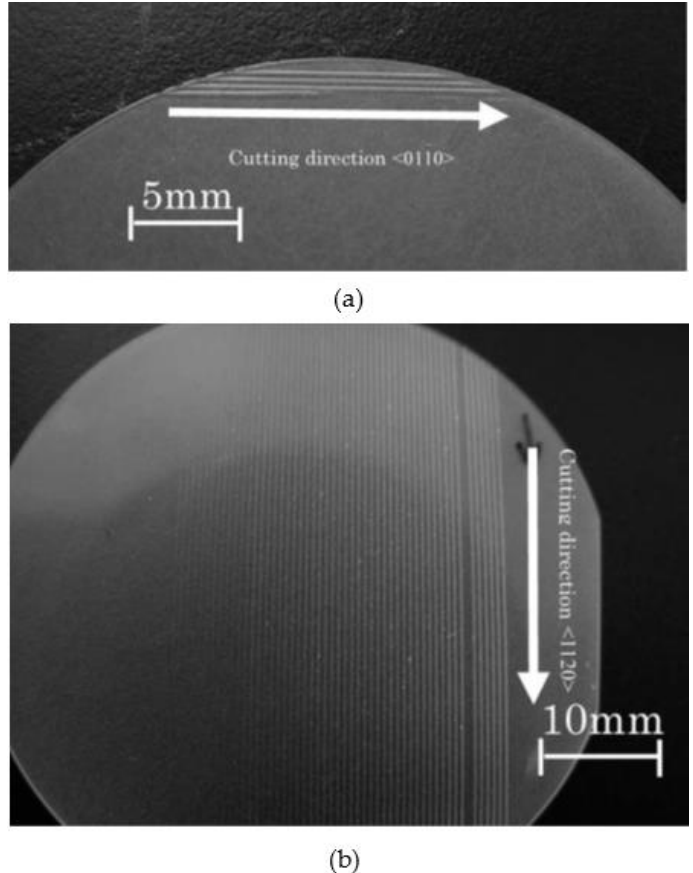
Figure 17. ( a ) Sapphire surface, after cutting by a commercial dicing blade, generates meandering lines and breaks after 50 mm of cutting length; ( b ) sapphire surface after cutting by fabricated dicing, where all blades can cut 1000 mm [72].